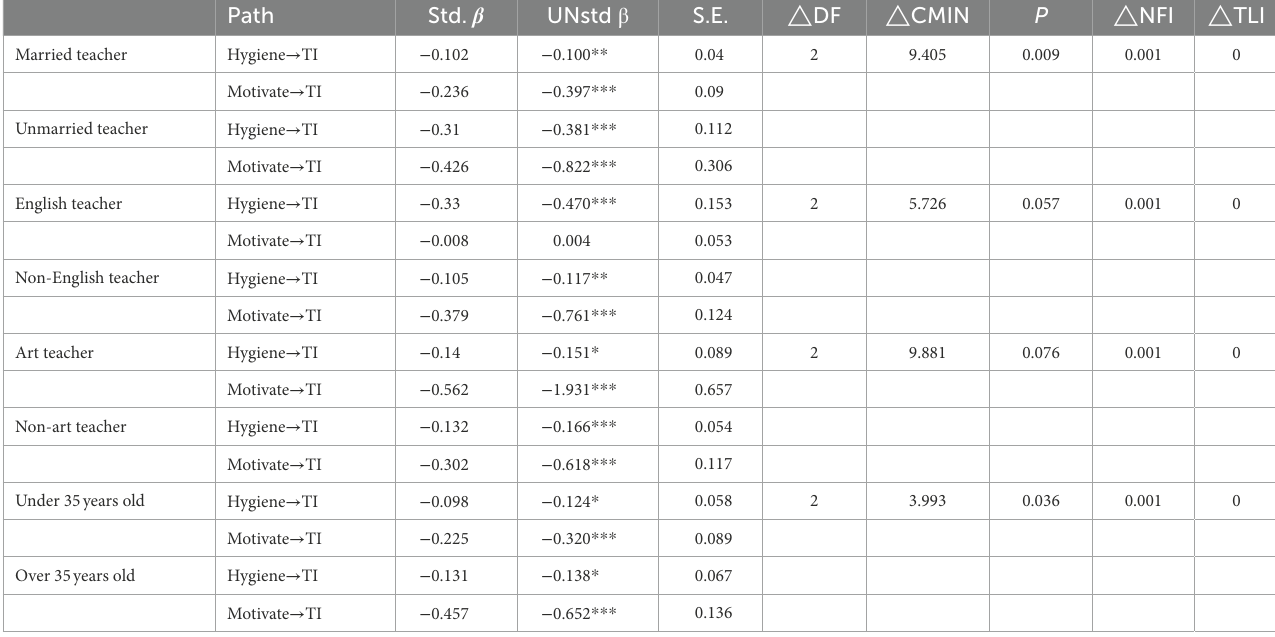
TABLE 6 Estimates from the multi-group SEM.